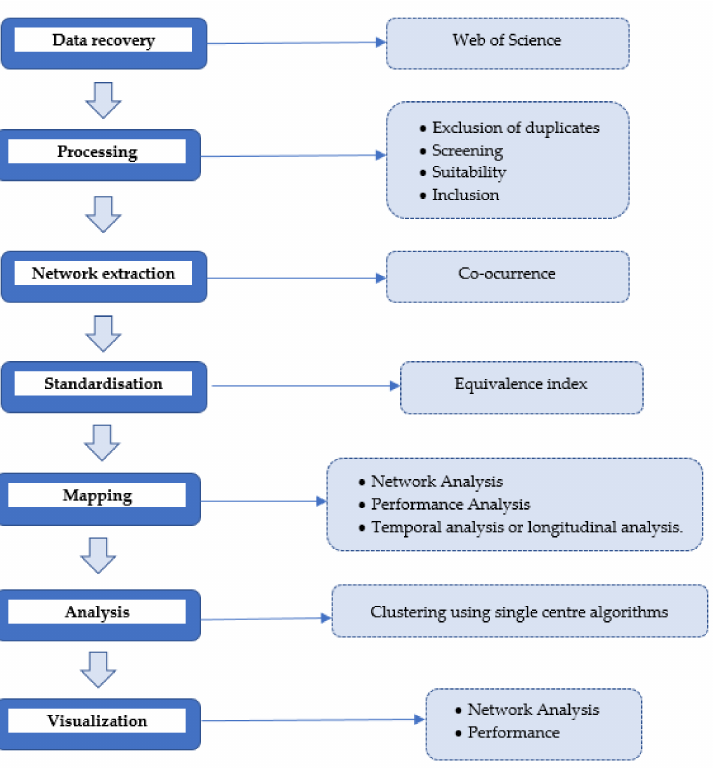
Figure 2. Schematic of general workflow in scientific mapping. Adapted from